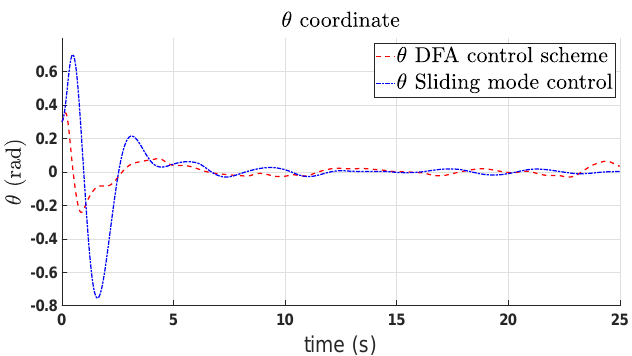
Figure 12. Behavior for θ for the implemented control schemes.